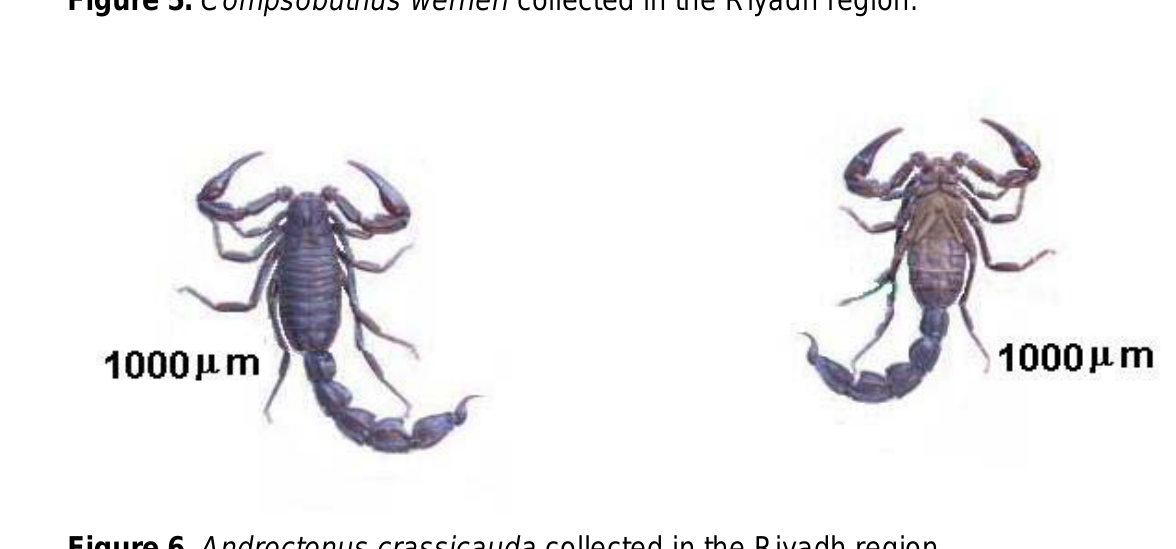
Figure 6. Androctonus crassicauda collected in the Riyadh region